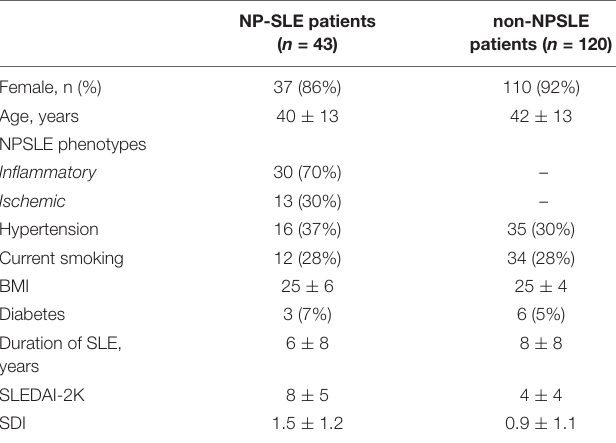
TABLE 1A | Patient population characteristics for the entire